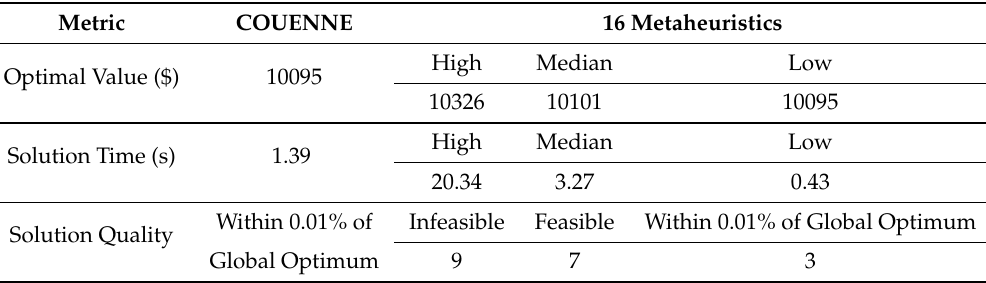
Table 7. Comparison of COUENNE solver versus past metaheuristic algorithm performance for test instance 3. Please note that optimal values reported for metaheuristics are only for feasible